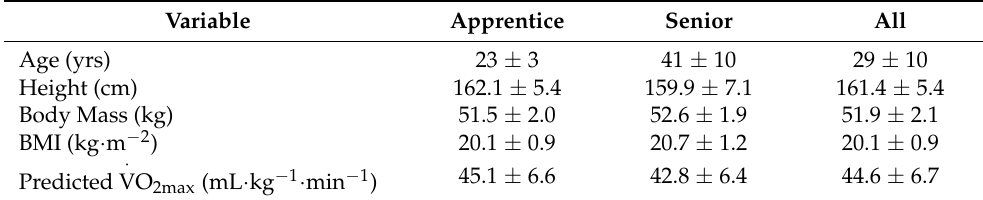
Table 1. Descriptive data (mean ± SD) for apprentice ( n = 8) and senior ( n = 4) jockeys.